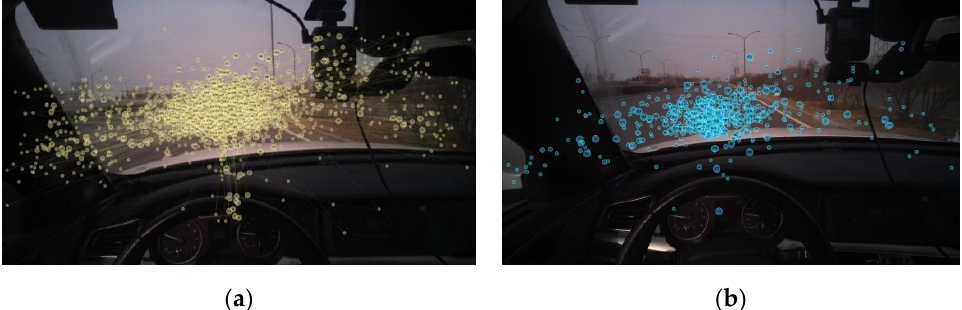
Figure 5. Separation results of I-DT algorithm: ( a ) original viewpoints and ( b ) separated fixation points.